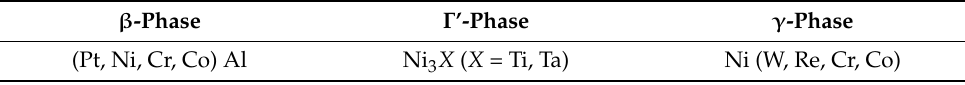
Table 2. Main phase and elements in the Pt-aluminide β bond